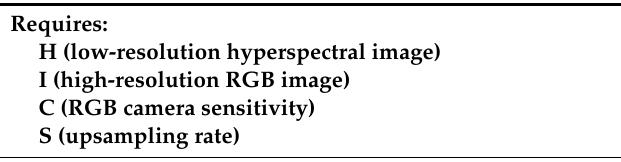
Table 1. Overall algorithm for the proposed